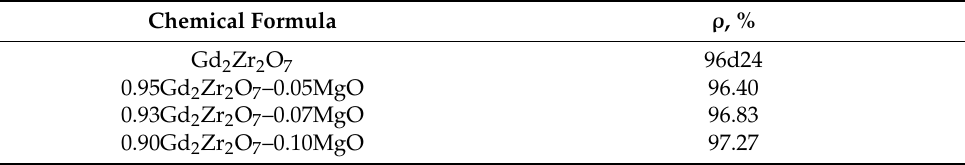
Figure 5. Impedance hodographs of 0.95Gd 2 Zr 2 O 7 -0.05MgO obtained in air in the temperature ranges of ( a ) 300–373 ° С , ( b ) 497–595 ° С , and ( c ) 650–799 ° С .